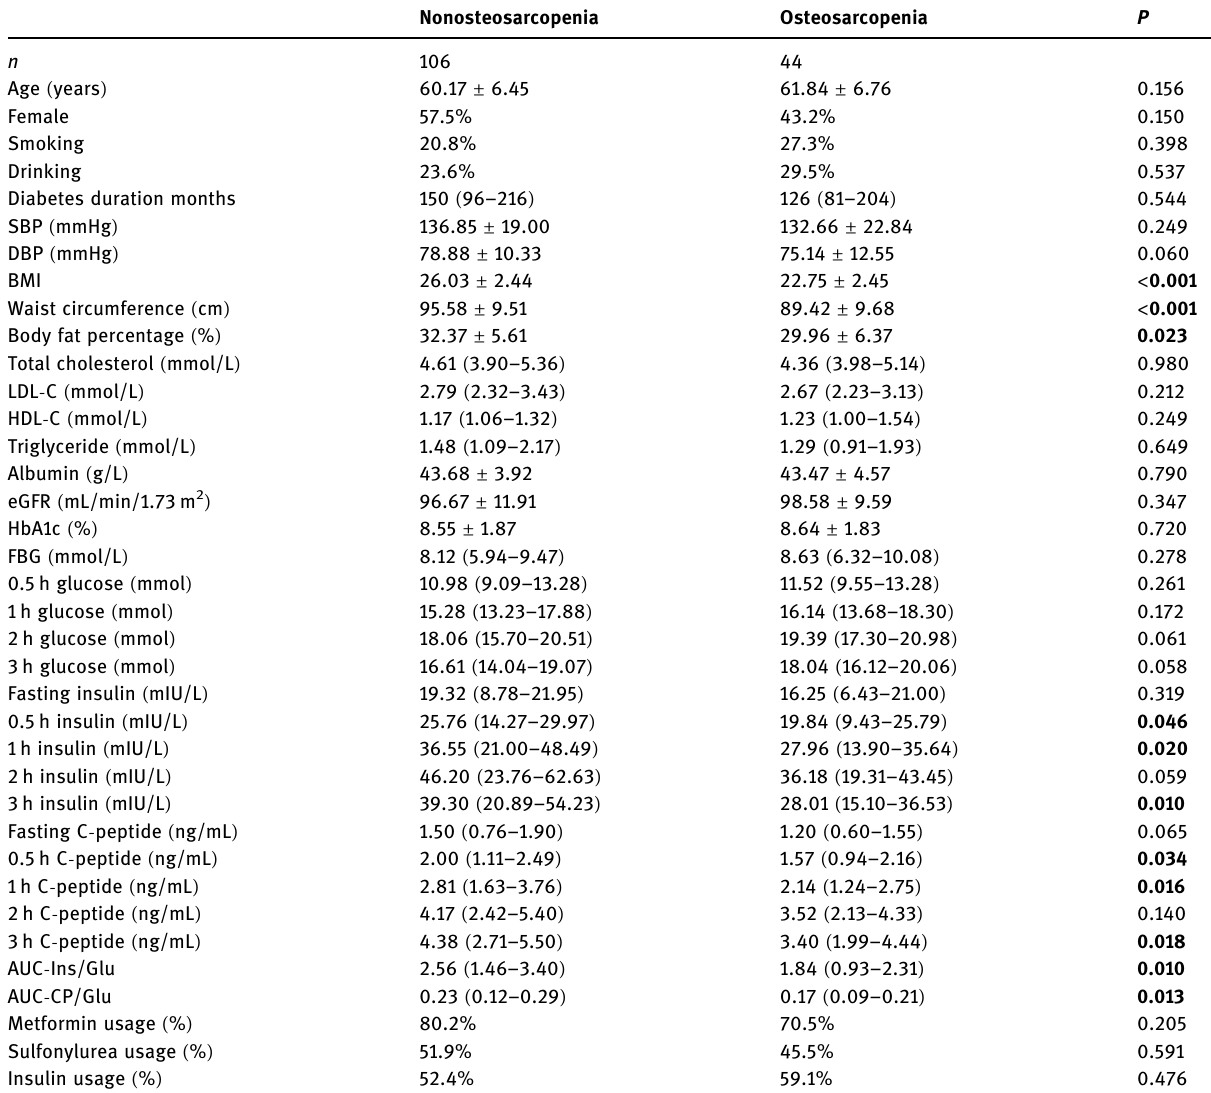
Table 1: Demographic and clinical parameters of the study population Nonosteosarcopenia